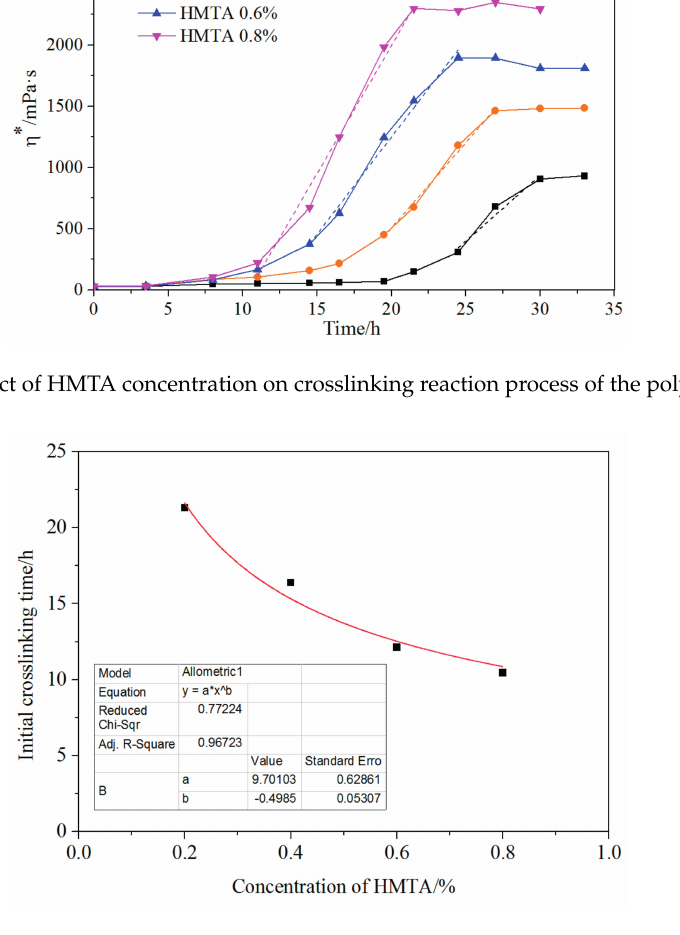
Figure 10. Effect of HMTA concentration on initial gelation time of the polymer